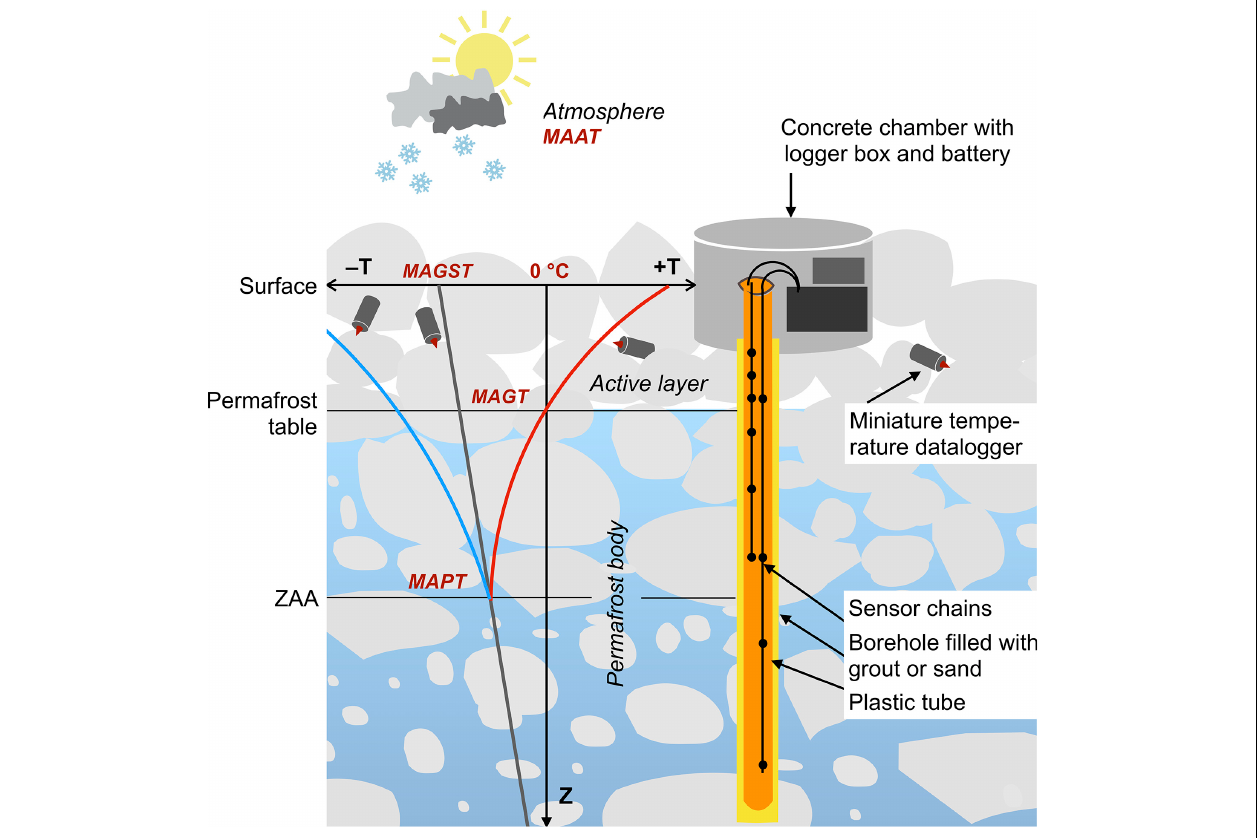
FIGURE 2 | Sketch of a basic setup for a borehole in ice-rich permafrost. A schematic temperature profile in the active layer and permafrost body is indicated on the left. The blue line of the profile denotes the annual minimum temperature, the gray line the annual mean temperature, and the red line the annual maximum temperature. MAAT, mean annual air temperature; MAGST, mean annual ground surface temperature; MAGT, mean annual ground temperature; MAPT, mean annual permafrost temperature; ZAA, zero annual